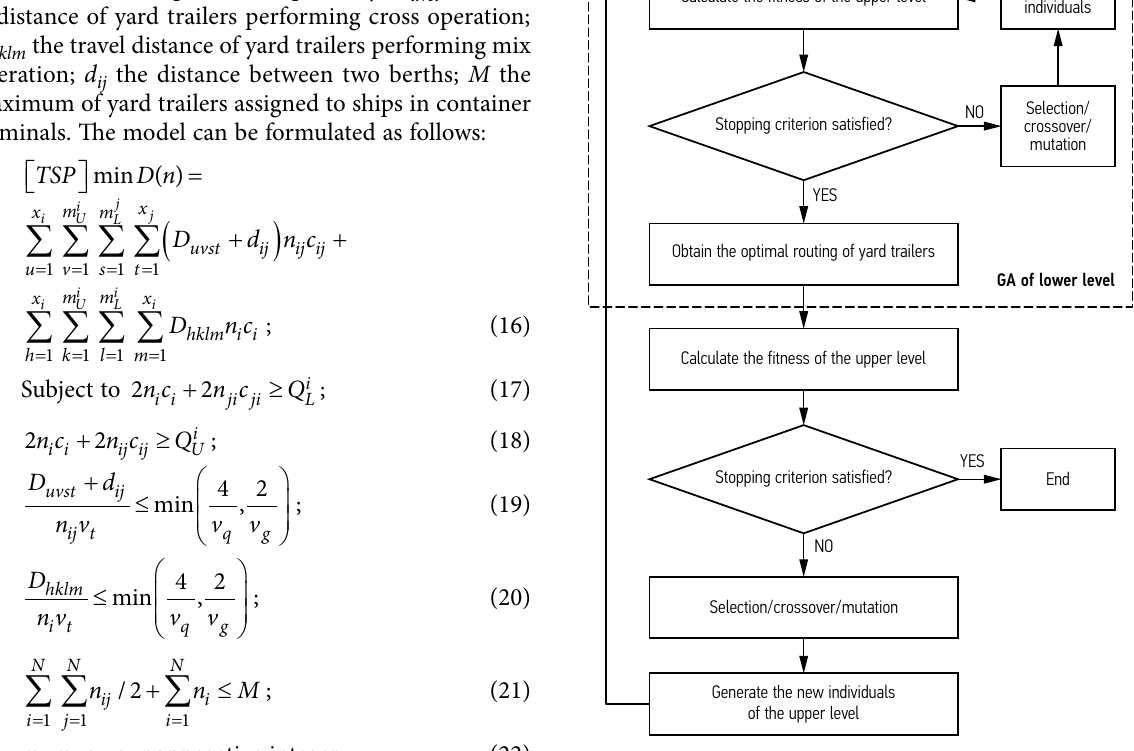
Fig. 3. Bi-level genetic